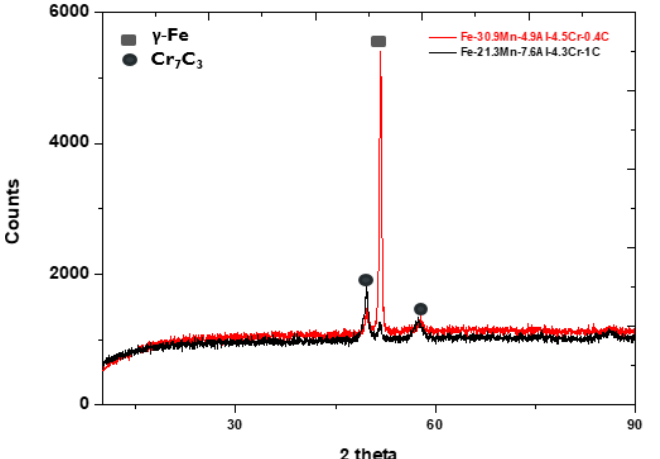
Figure 4. X-ray diffraction pattern of Fe-30.9Mn-4.9Al-4.5Cr-0.4C and Fe-21.3Mn-7.6Al-4.3Cr-1C low-density steels.